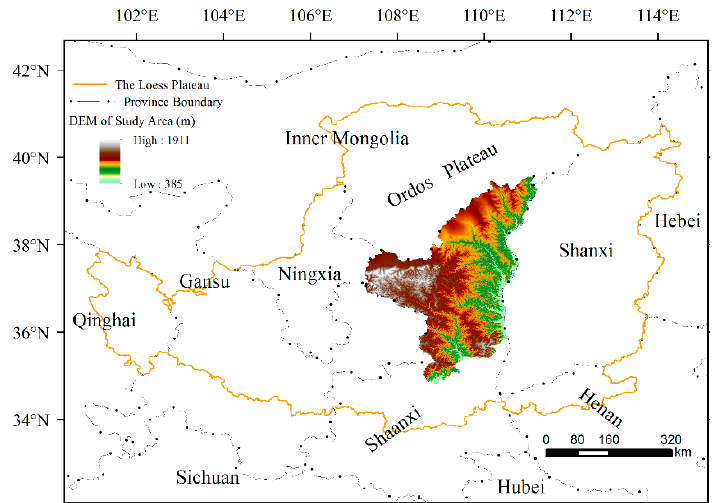
Figure 1. The location of the study area.